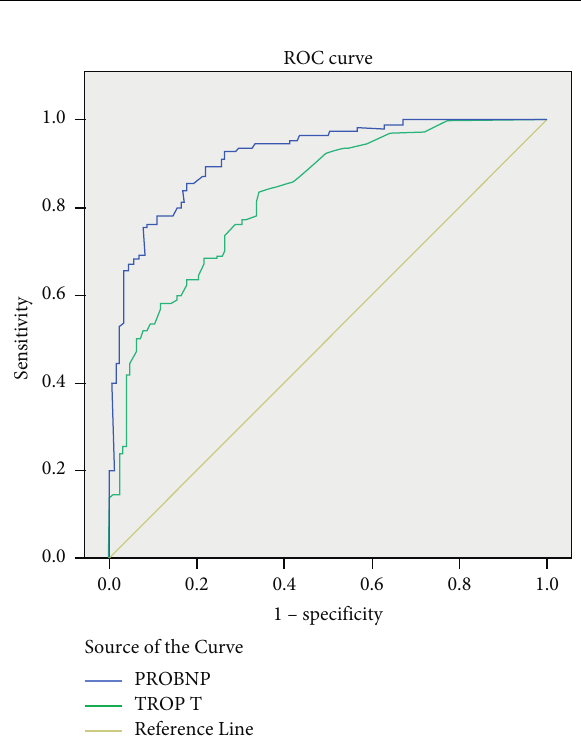
Figure 3: Prediction of pulmonary hypertension ( ≥ 20 mmHg) by serum pro-BNP and troponin T values (receiver-operating char- acteristic